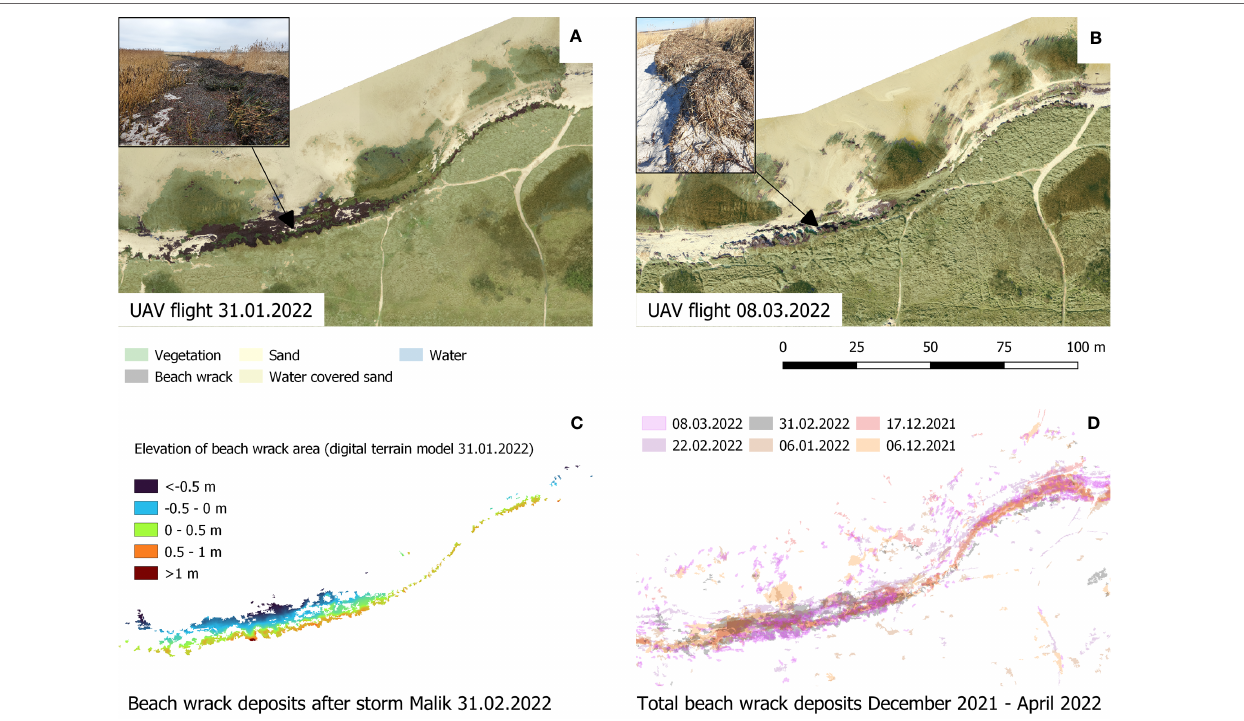
FIGURE 6 | Zoom into the “beach wrack highway” along the east-west footpath. While fresh sea grass leaves were visible in the beach wrack during December and January (A) , the beach wrack started to get covered by sand and mixed with Phragmites litter and broken stems in February and March (B) . This underlines the importance of event-based monitoring. The elongated cliff-like structure becomes also obvious looking at the digital elevation model based on UAV photogrammetry with the open-source software WebODM for the 31.01.2022 after storm Malik (C) . Beach wrack accumulated behind “the first line of defense” (mainly Phragmites patches) along the east-west footpath connecting the two sandy areas where most tourists reside. (D) Almost no beach wrack accumulated along the north-south